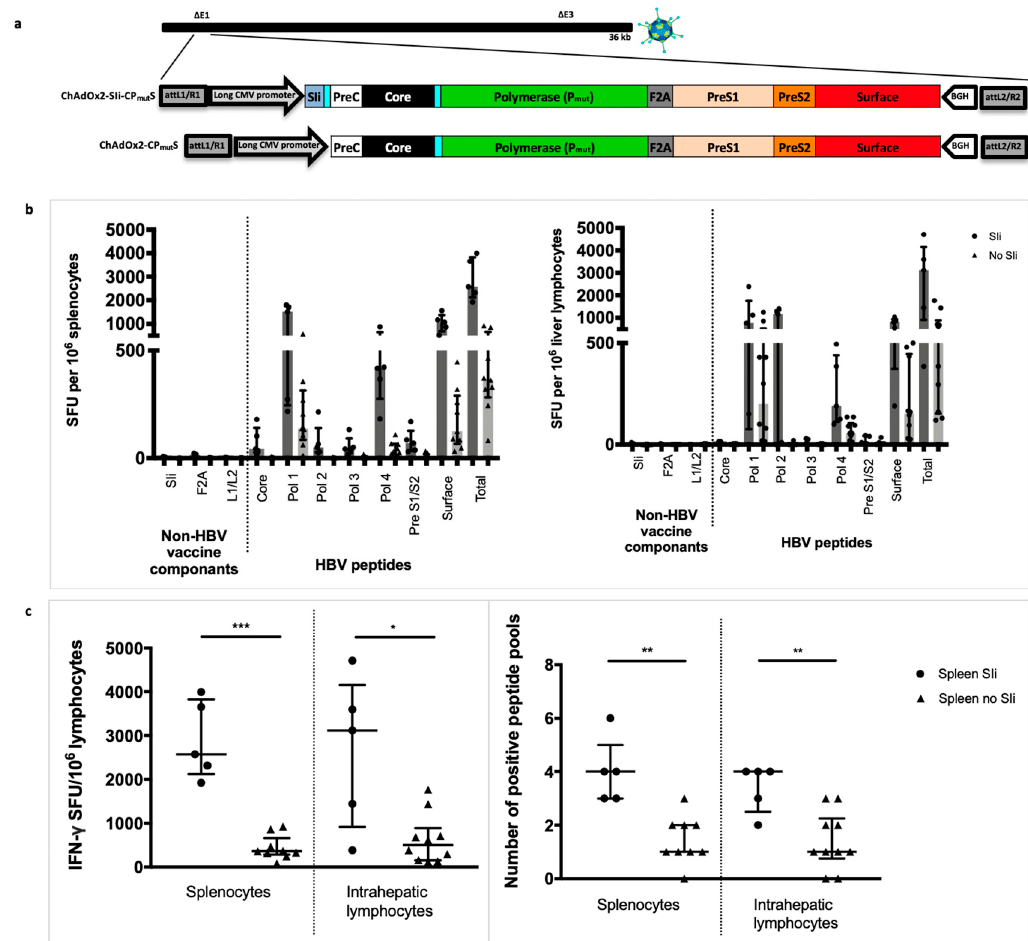
Figure 3. Tethering transmembrane region of shark invariant chain to the HBV immunogen enhances the magnitude and breadth of vaccine induced T cell responses. Long-CMV promoter (LP) based mammalian expression cassettes, encoding SIi-CP mut S or CP mut S immunogens, were inserted into E1 locus of replication deficient ChAdOx2 vector and recombinant ChAdOx2-SIi-CP mut S and ChAdOx2-CP mut S viruses were generated in T-REx ™ -293 cells ( a ). CD1 mice were vaccinated intramuscularly with 5 × 10 7 infectious units of ChAdOx2 encoding either SIi-CP mut S ( n = 5) or CP mut S ( n = 9–10. Splenocytes (left panel) and intrahepatic lymphocytes (right panel) were extracted 14 days after vaccination and plated in interferon-gamma (IFN γ ) ELISpot assays with pools of overlapping peptides corresponding to the vaccine immunogen ( b ). T cell response magnitude was measured by the number of IFN γ spot forming units (SFU) per million lymphocytes ( c , left panel) and breath was measured by the number of positive peptide pools ( c , right panel, over 100 IFN γ SFU / million cells defined as positive). Median and interquartile ranges are shown. Mann–Whitney tests were used for statistical comparison of medians between groups. * p < 0.05, ** p < 0.01, *** p <